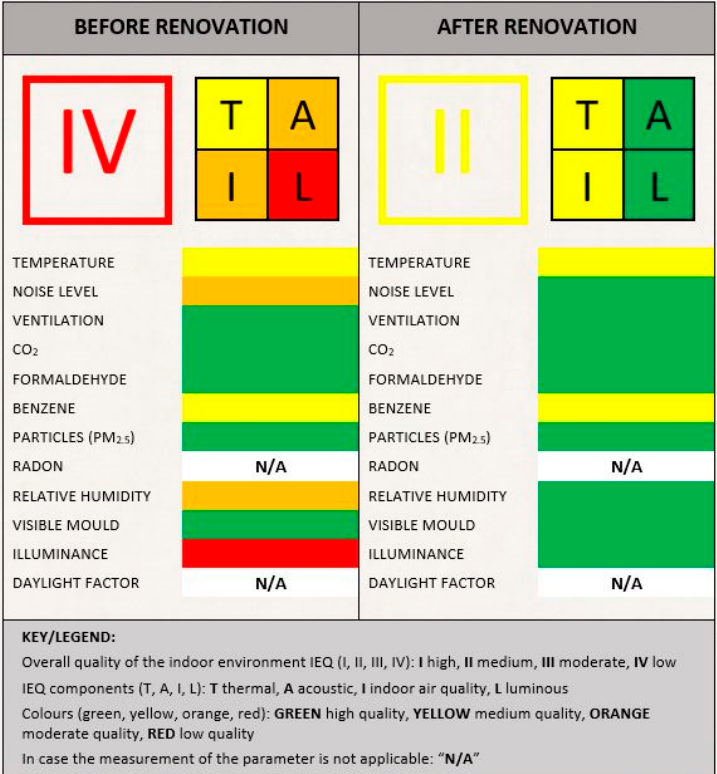
Figure 7. TAIL results before ( left ) and after ( right ) the renovation on Building 8, Politecnico di Milano—Lecco Campus.